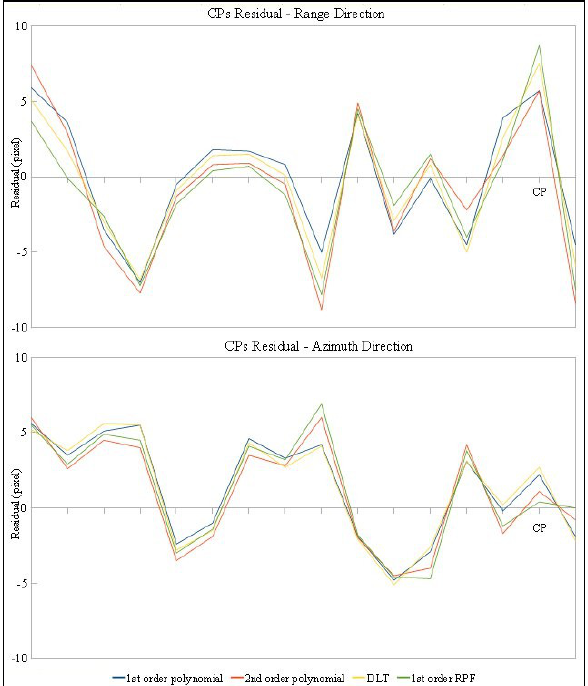
Figure 9. Test C: CPs residuals in Range and